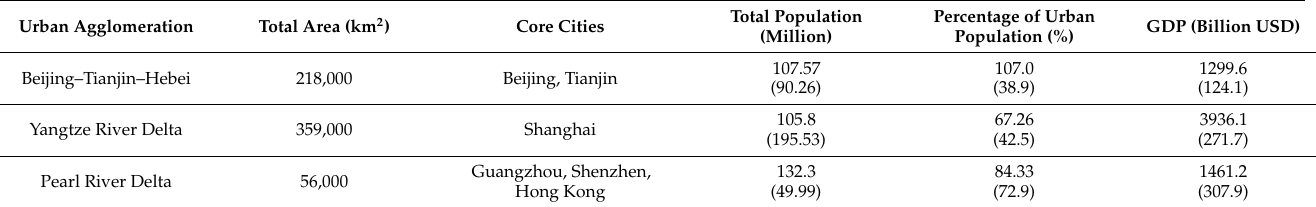
Table 1. Comparison of the socioeconomic statuses of the three most popular urban agglomerations in 2000 and